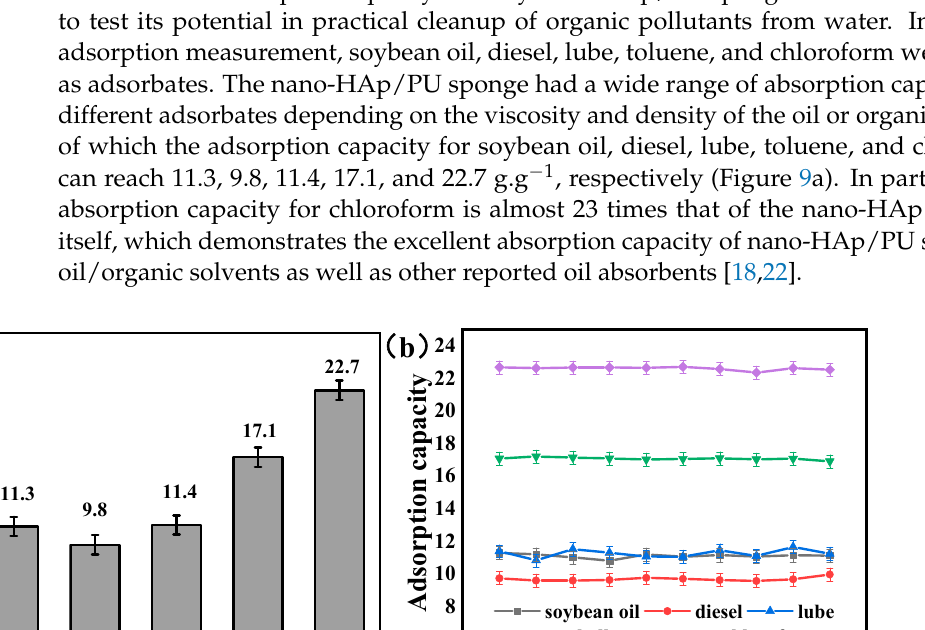
10 of 13 Figure 8. Selective oil absorption performance of the nano-HAp/PU sponge: ( a ) removal of diesel (dyed with oil red) below